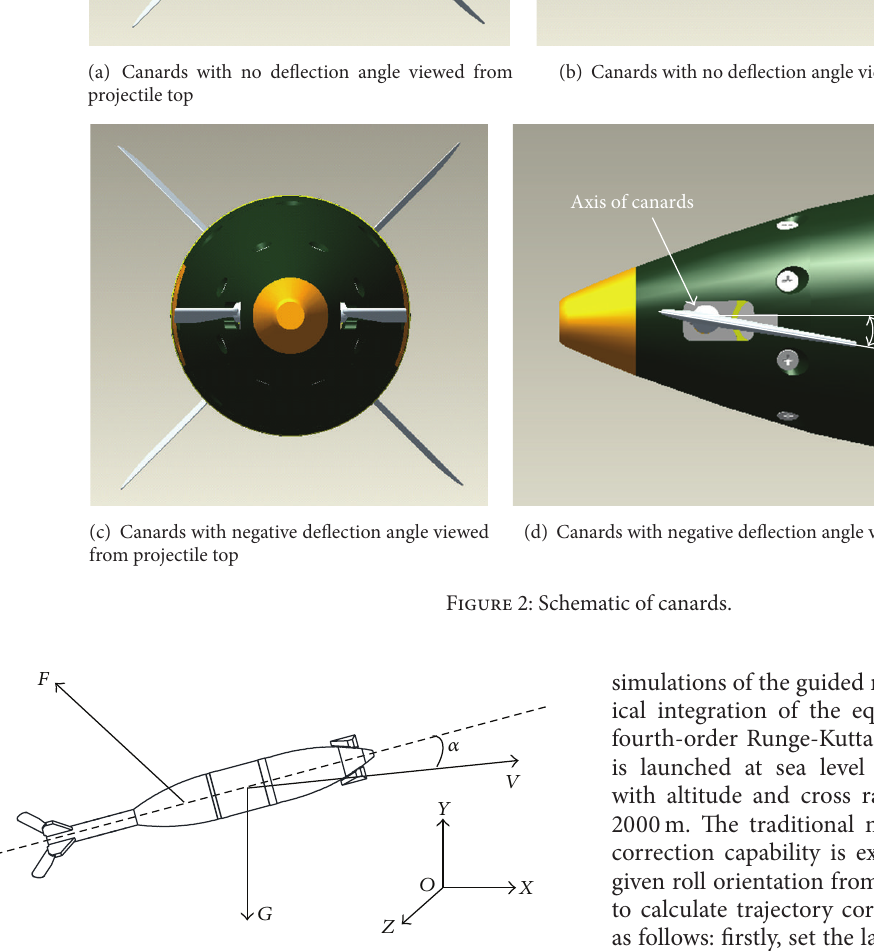
Figure 3: Schematic of forces on guided mortar